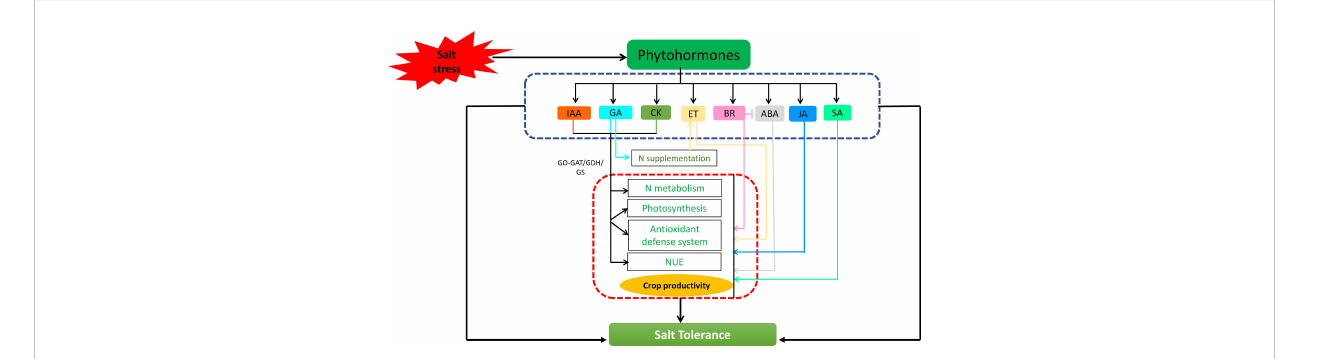
FIGURE 3 Phytohormones have been found to regulate nitrogen metabolism during salt stress, either in conjugation with nitrogen sources or by interacting with other phytohormones leading to improved physio-biochemical attributes, and promoting plant growth and development under salt